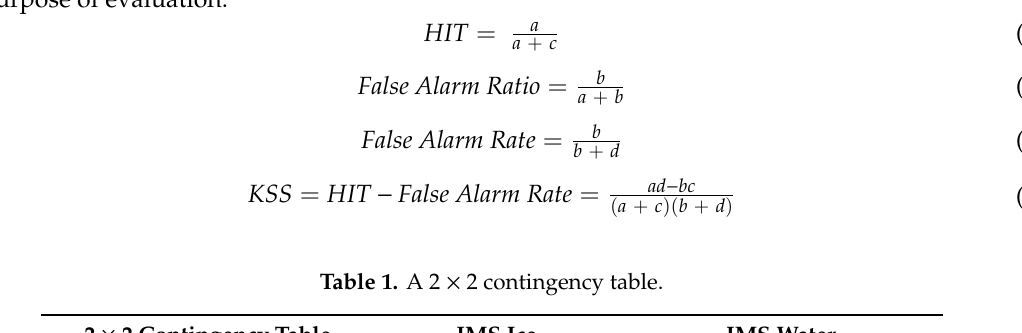
Table 1. A 2 × 2 contingency table.